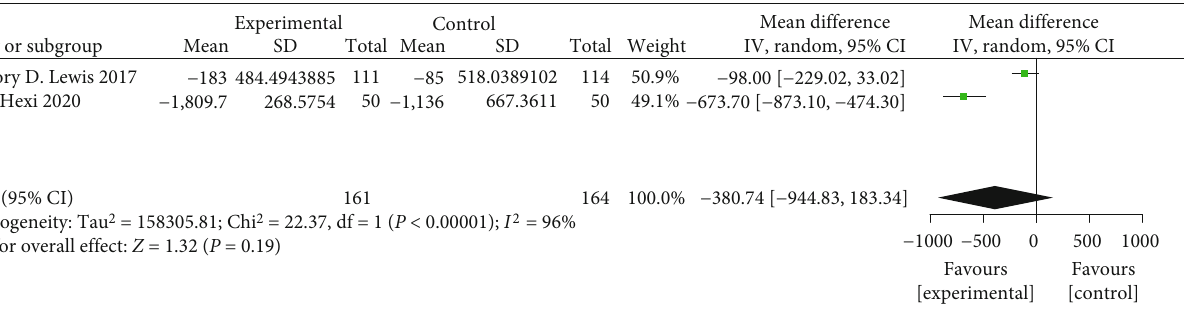
Figure 10: Forest plots of the e ff ect of oral iron on